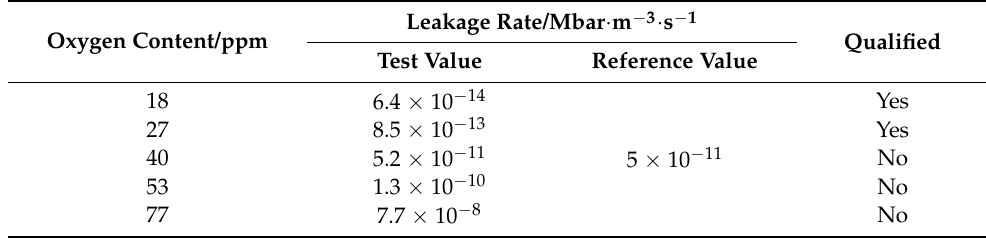
Table 2. Leakage rates of package devices using Au-20Sn solders with different contents of